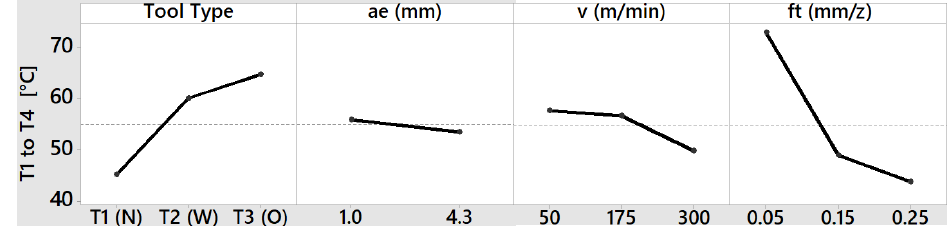
Figure 6. Main effect plot results on the Ti6Al4V plaque temperature for thermocouples T1 to T4.